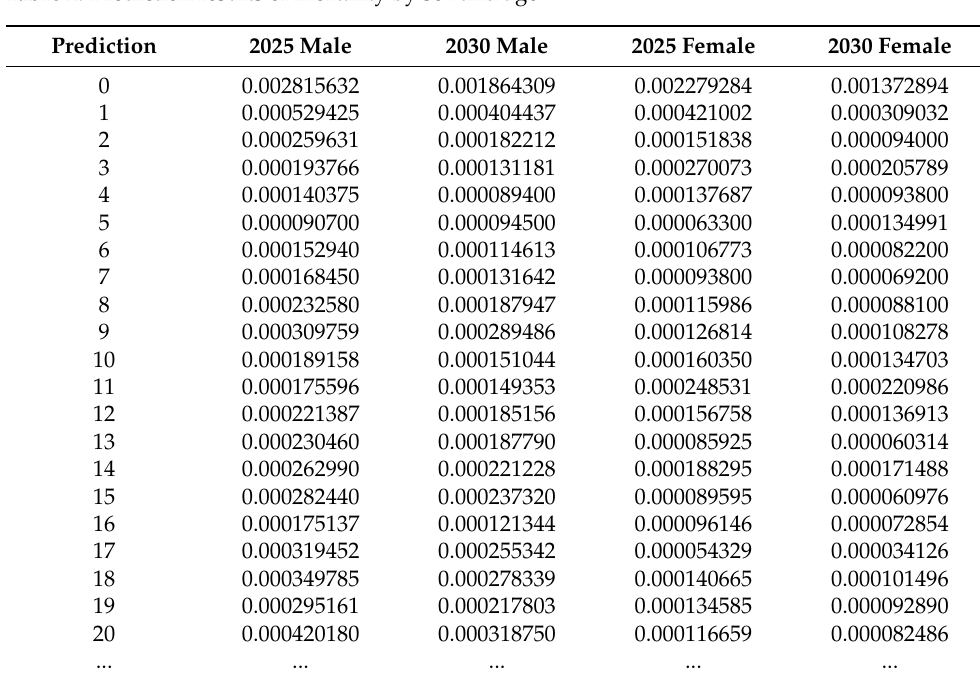
Figure 7. Comparison chart of predicted mortality. Table 2. Prediction results of mortality by sex and